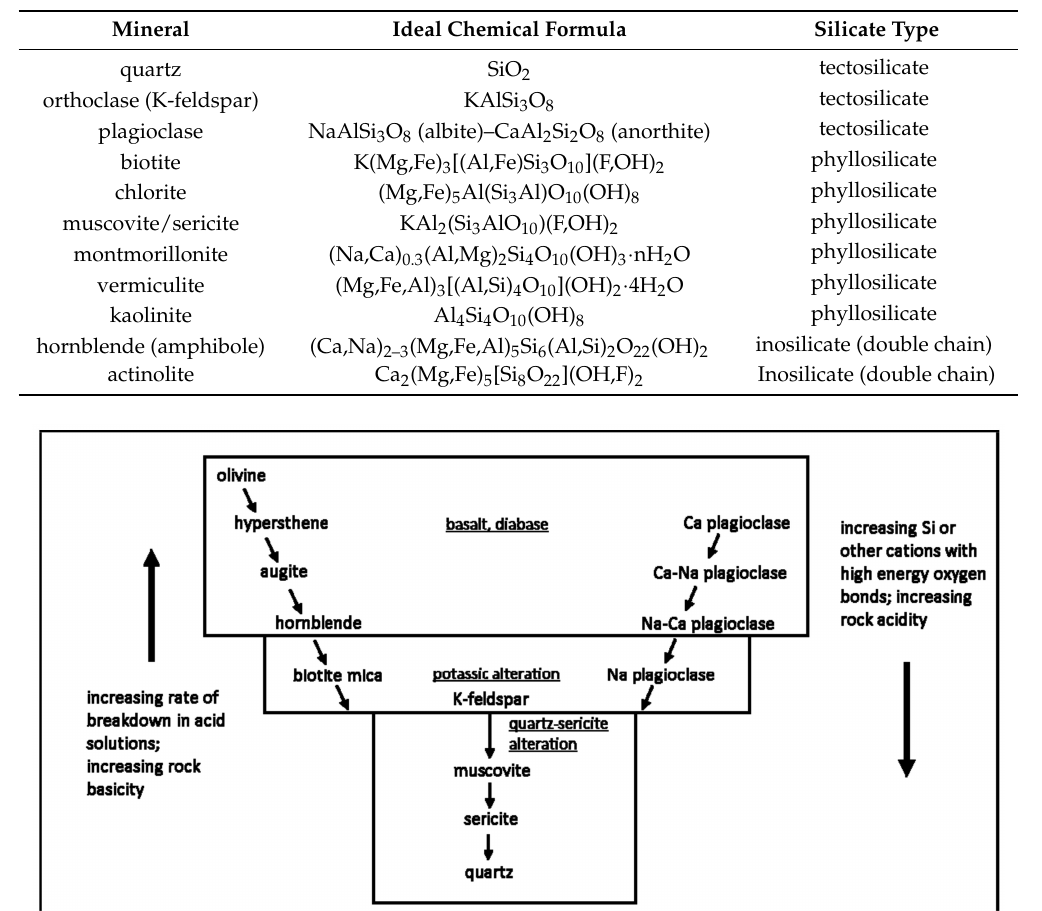
Figure 1. Common rock-forming minerals ordered by crystallisation and dissolution kinetics in acid sulfate leach solutions [8].